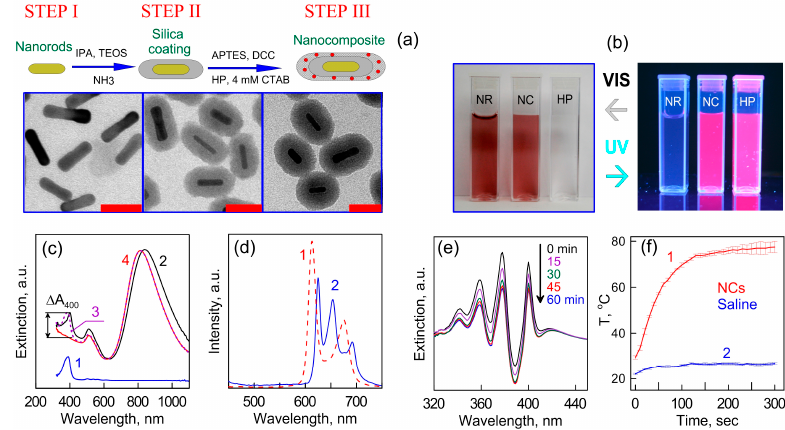
Figure 1. Schematic representation of the basic steps in fabrication of nanocomposites AuNR/SiO 2 -HP containing a plasmonic core, a primary silica shell, and a secondary mesoporous silica shell doped with HP molecules. Scale bars are 50 nm ( a ); Photos of cuvettes with silica-coated AuNRs (NR), nanocomposites (NCs), and an HP solution taken under visible (VIS) and UV light illuminations ( b ); Extinction spectra of HP (curve 1), NC (curve 2), and NR (curve 4) solutions; the spectrum 3 (dotted curve 3) was obtained by the superposition of spectra 1 and 4. The difference ∆ A 400 is roughly equal to the extinction maximum of HP with a concentration of 7 mg/L (curve 1) ( c ); Fluorescence spectra of HP (1) and NC (2) solutions measured under 405-nm excitation ( d ); For these measurements, all solutions were diluted 1:16. Absorption spectra of a mixture of ABDA and NCs under illumination by a 633-nm laser for different exposures from 0 to 60 min ( e ); Time-dependent increase in the temperature of NC suspension (1) and saline (2) under NIR laser (808 nm, 2 W/cm 2 ) irradiation ( f ). Reproduced from [37,38] with permission from the Springer and Wiley.